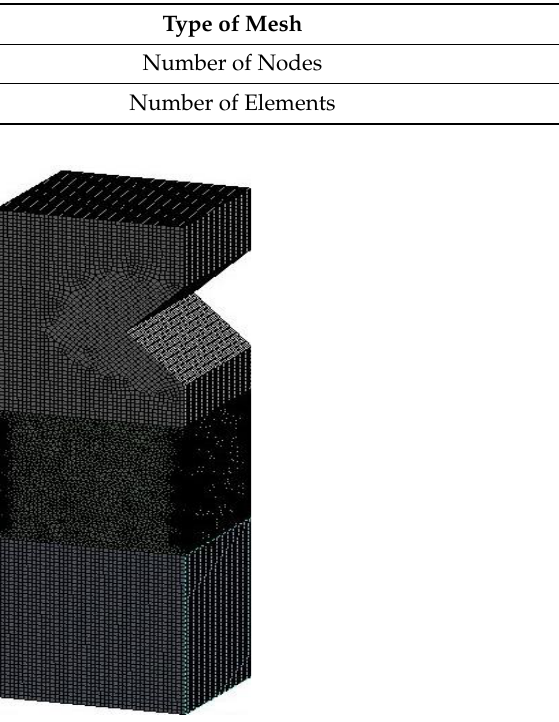
Figure 7. Detailed meshing of supercritical boiler.